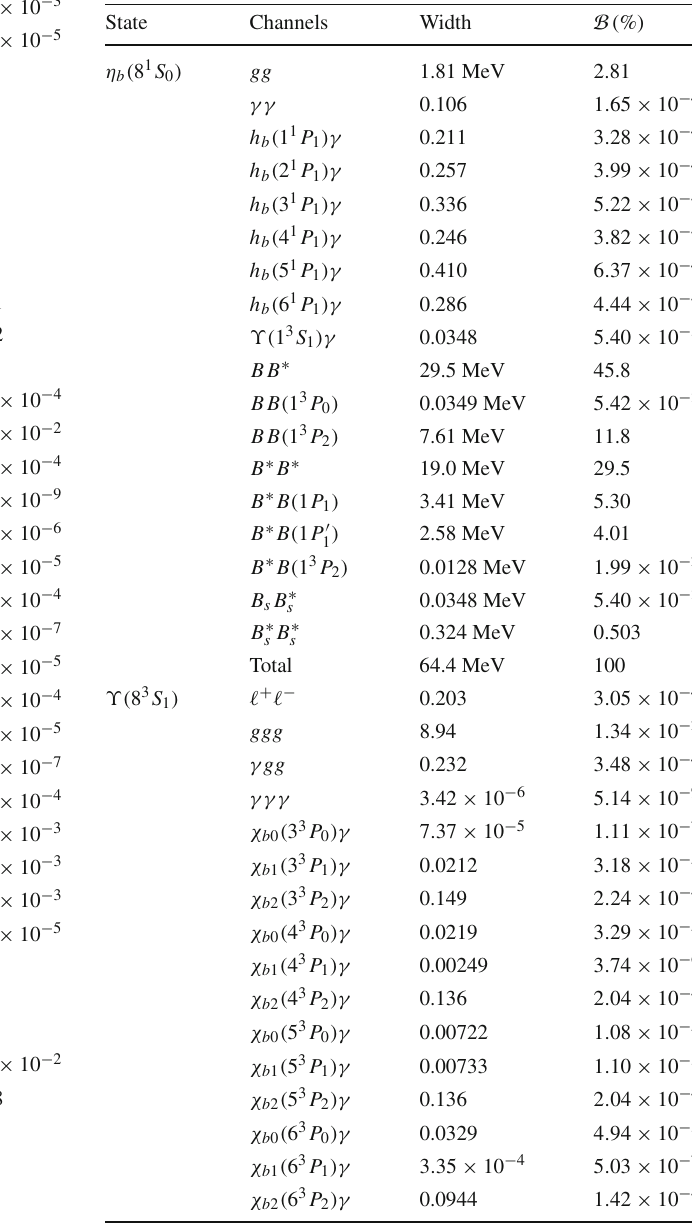
Table21 PartialwidthsandbranchingratiosoftheOZI-allowedstrong decay, annihilation decay, and radiative transition and the total widths for the 8 S bottomonium states. The width results are in units of